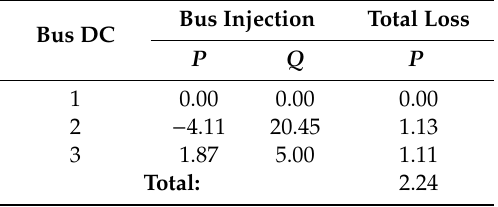
Table A20. Results of the mixed AC / DC PF calculations in Case 5. DC bus data.